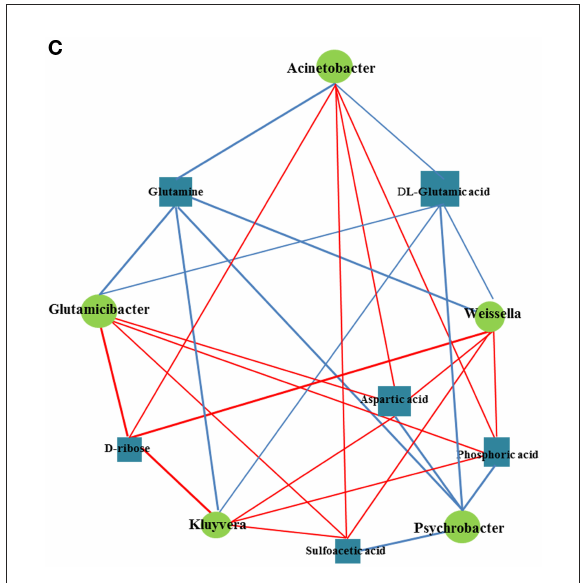
FIGURE4 Correlation analysis of urine microorganisms and metabolites. (A) Hierarchical clustering heat map of spearman correlation analysis of significant difference between microbiota and metabolites. In the hierarchical clustering heat map, each row represents a significantly different genus, and each column represents a significantly different metabolite. The tree branches on the left represent the results of clustering differential bacterial genera, and the upper tree branches represent the results of clustering analysis on differential metabolites. Clusters of significantly different metabolites or different genera that appear in the same cluster have a similar correlation pattern. Each cell in the hierarchical clustering heat map contains two kinds of information (correlation coefficient r and p -value). The correlation coefficient r is represented by color. r > 0 means positive correlation, which is represented by red; r < 0 means negative correlation, which is represented by blue, and the darker the color, the stronger the correlation. p -value reflects the significant level of the correlation, p -value < 0.05, represented by * ; p -value < 0.01, represented by ** . (B) Matrix heat map of spearman correlation analysis of significant difference between microbiota and metabolites related to arginine, glutamatergic and GABAergic synthesis. The matrix graph not only shows the correlation between the significantly different bacteria and the significantly different metabolites, but also the correlation between the significantly different metabolisms and the significantly different bacteria. Taking the blue dotted line in the picture as the dividing line, the correlation coefficient matrix heat map can be divided into four icons. The upper left corner shows the correlation between significantly different bacterial groups, the lower right corner shows the correlation between significantly different metabolites, and the upper right corner and the lower left corner both show the significantly different bacterial groups and Correlations between significantly different metabolites, mirror symmetry. The Spearman correlation coefficient value r is between − 1 and + 1. The correlation coefficient r is represented by color. r > 0 indicates a positive correlation, which is shown in red. Darker colors indicate stronger correlations. (C) Network diagram of spearman correlation analysis of significant difference between microbiota and metabolites related to arginine, glutamatergic and GABAergic synthesis. Circles in the figure represent significantly different genera, and rectangles represent significantly different metabolites. The color of the line represents the positive and